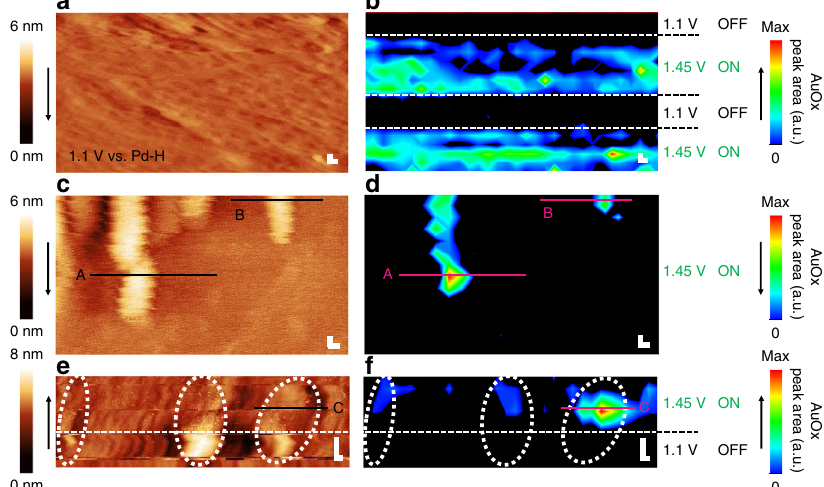
Fig. 2 Operando 2D chemical imaging of catalytic defect reactivity. a , c , e EC-STM images of Au(111) in 0.1 M H 2 SO 4 . Scan speed: 1 line s − 1 . b , d , f Corresponding EC-TERS maps reconstructed from the gold oxide (AuOx) band intensity. Pixel size: 9.4 nm, 3 s b , f or 1 s d spectral acquisition time/pixel. a – f Tunneling current ( I t ) = 1 nA, E tip = 1.0 V vs. Pd-H , E sample as indicated; scale bars = 10 nm. Black arrows indicate scan directions. Dotted white lines are guides to the eye. Solid black and pink lines are line pro fi les analyzed in Fig.